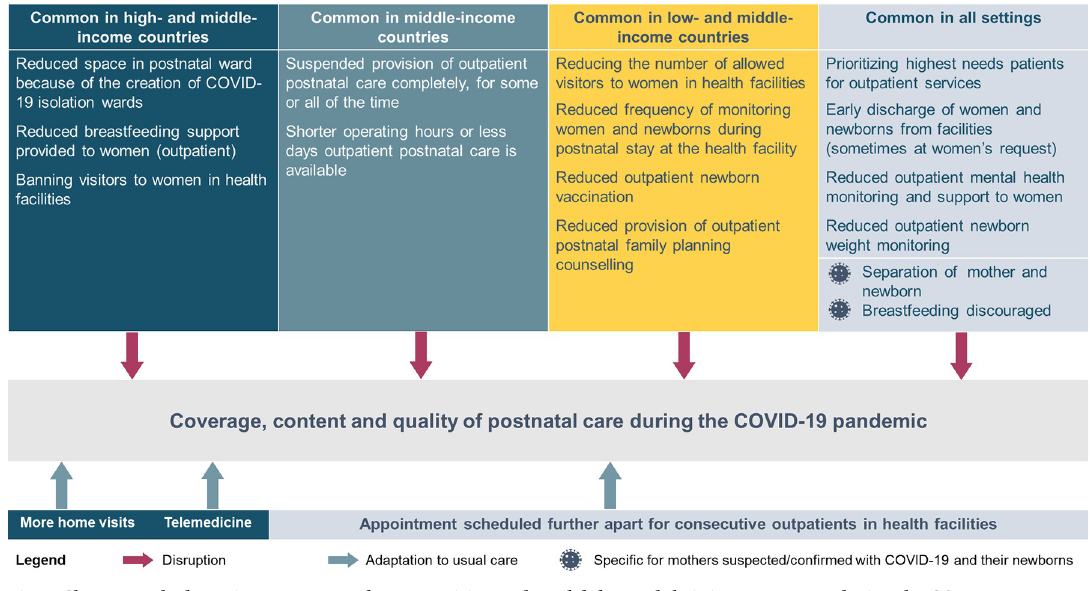
Fig 6. Changes and adaptations to postnatal care provision and availability and their impact on care during the COVID-19 pandemic, by country income